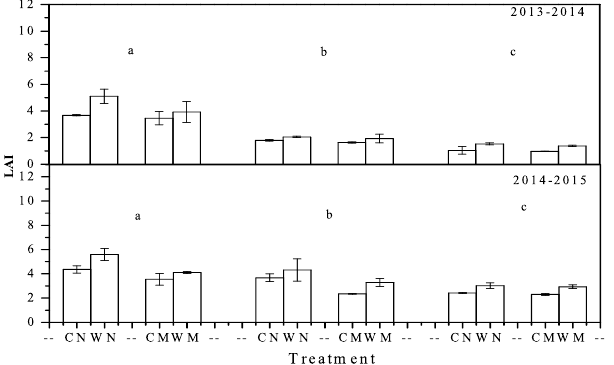
Figure 6. Leaf area index at the jointing ( a ), heading ( b ), and filling ( c ) stages in 2013–2014 and 2014–2015 winter wheat growing seasons. WN represent wide-precision planting with non-mulching, CN represent conventional-cultivation planting with non-mulching, WM represent wide-precision planting with straw mulching, and CM represent conventional-cultivation planting with straw mulching, respectively. Vertical bars are standard